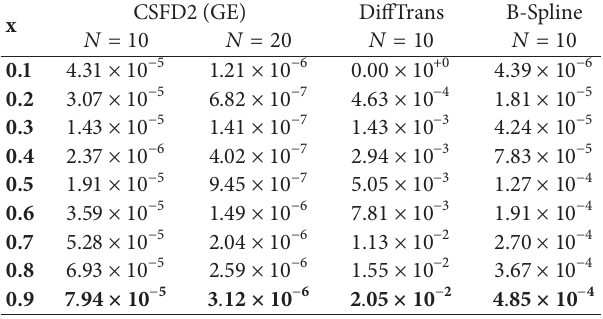
Table2:ComparisonbetweenCSFD2(GE),DiffTrans,andB-Spline method for Example